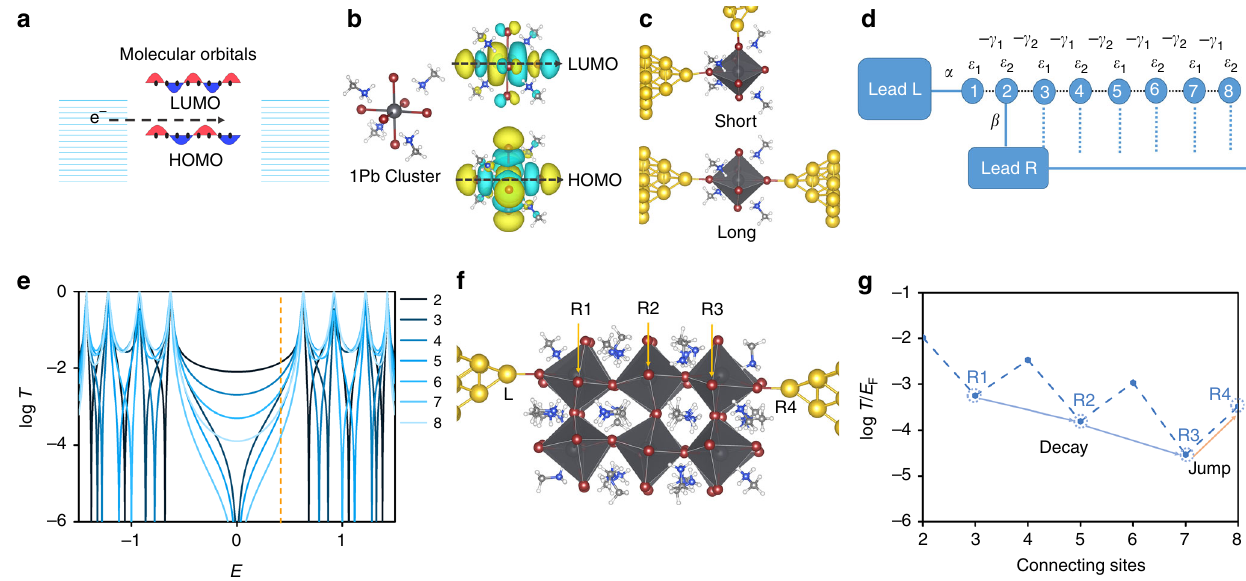
Fig. 1 The orthogonality of molecular orbitals and QI of 1Pb perovskite cluster. a Schematic of coherent tunneling across a molecule, where the HOMO and LUMO of a one-dimensional chain of 8 sites are plotted. b The chemical structure of a relaxed 1Pb MAPbBr 3 (MA = CH 3 NH 3 + ) cluster, and its corresponding HOMO and LUMO. The number of nodes is 4 and 5 in the direction indicated by the black dashed lines. c A relaxed 1Pb MAPbBr 3 cluster is embedded between two gold electrodes, with two different connections, denoted ‘ Short ’ and ‘ Long ’ separately. Pb, Br, N, C, H, and Au atoms are represented by large gray, purple, blue, small gray, white, and yellow balls. d Schematic of tight-binding model comprising an 8-site diatomic chain as the scattering region, where site 1 is connected to left lead L and sites 2 to 8 are connected sequentially to right lead R. e The corresponding transmission functions when lead R is attached different sites from 2 to 8. The Fermi energy is indicated by the yellow line. f Relaxed conformation for a 12Pb MAPbBr 3 cluster attached to two gold electrodes. The Br atom connected to left lead is labeled as ‘ L ’ , while the Br atoms attached to right lead are labeled ‘ R1 ’ , ‘ R2 ’ , ‘ R3 ’ , and ‘ R4 ’ . g Transmission function T(EF) at the Fermi energy for different sites connected to the right